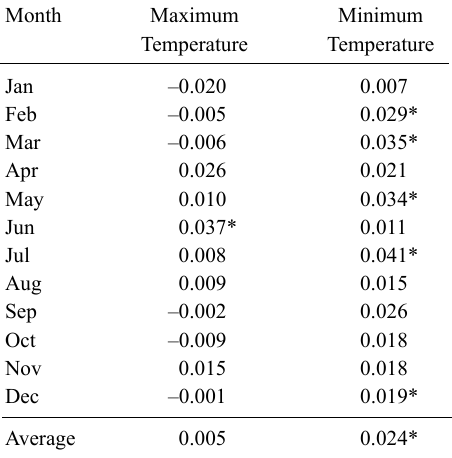
Seasonal trends of maximum, minimum and aver- age temperatures (°C p.a.) for the period 1960 to